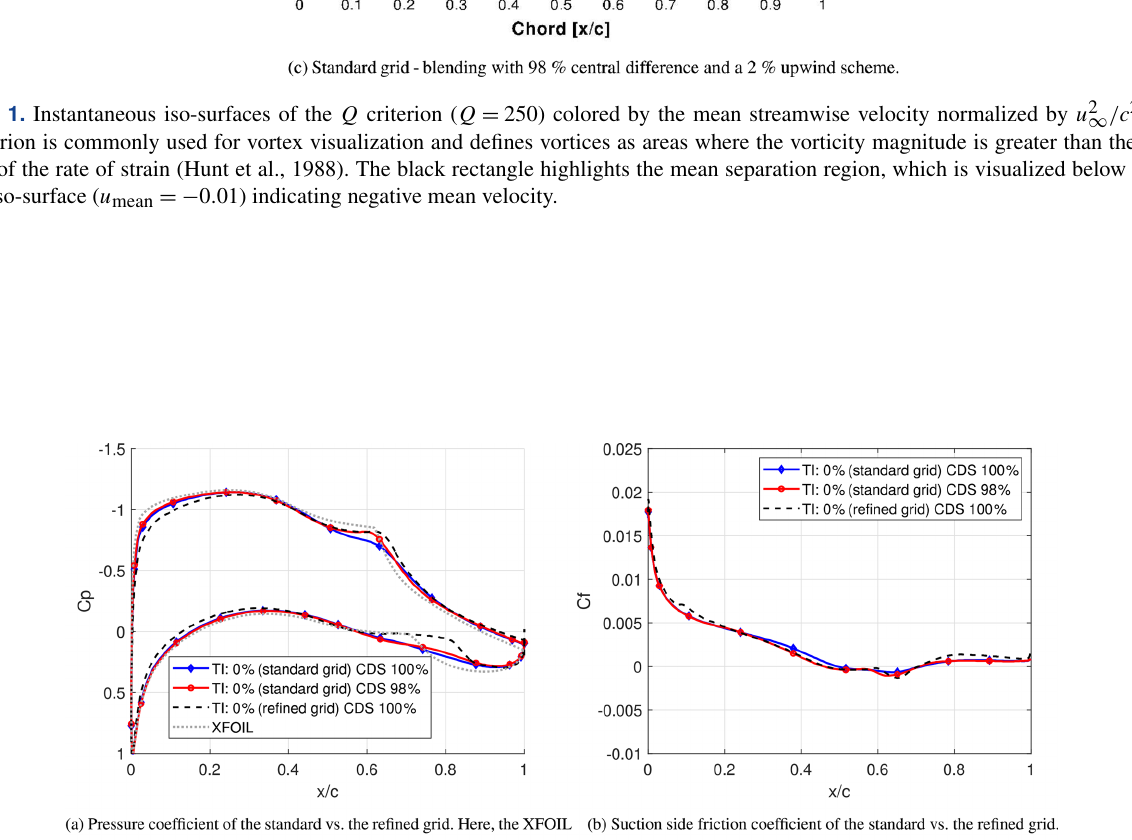
Figure 2. Comparison of time and spanwise averaged statistics at TI = 0%.